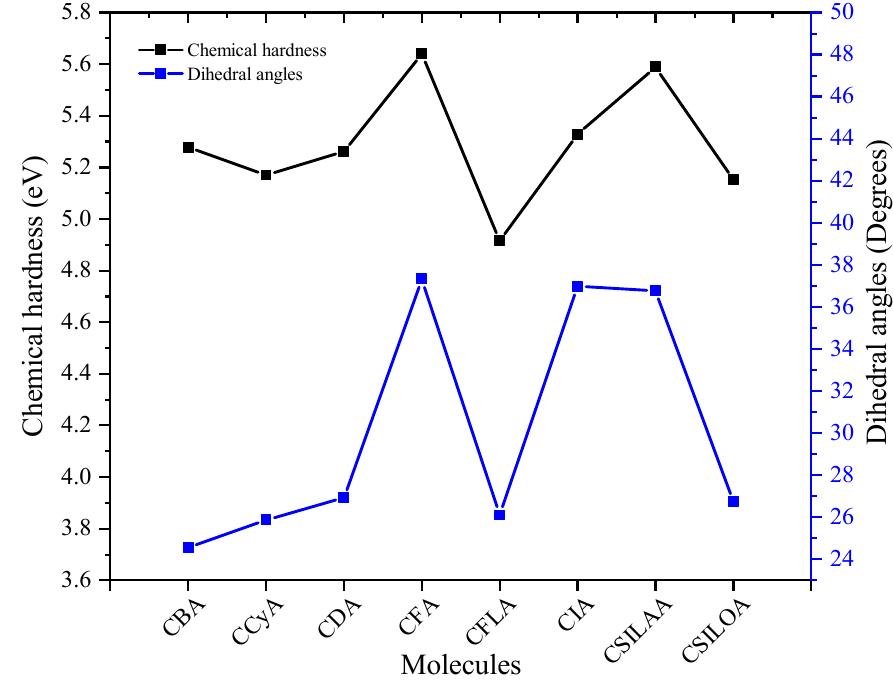
Figure 6. Comparison between chemical hardness (D- π ) dihedral angles of the carbazole-based dyes.